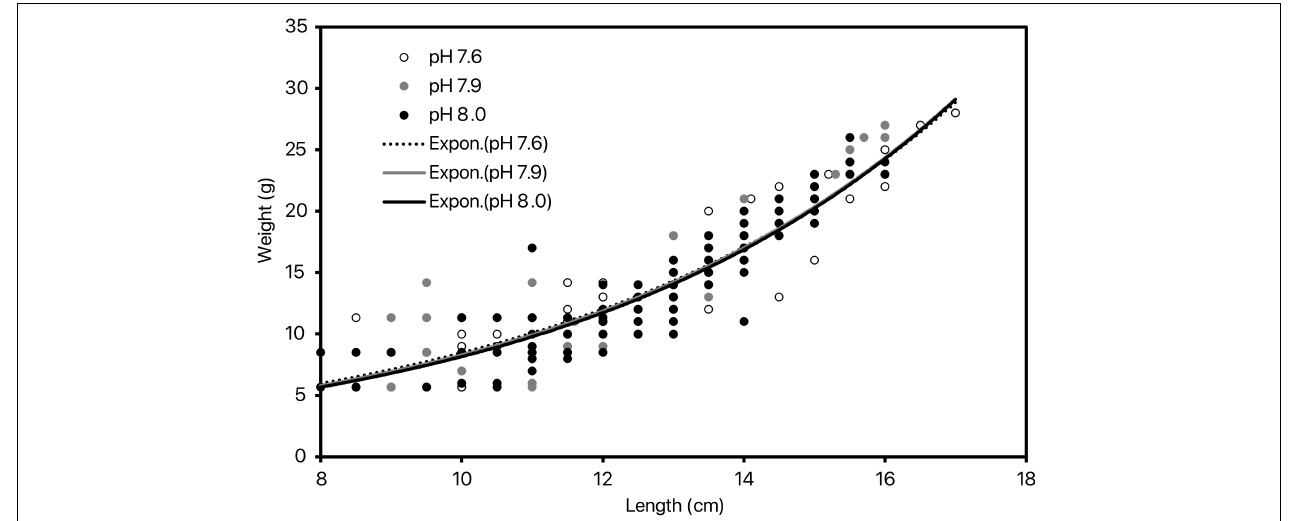
FIGURE 3 | The exponential relationship between shrimp length (cm) and weight (g) at the 3 tested nominal pH NIST .